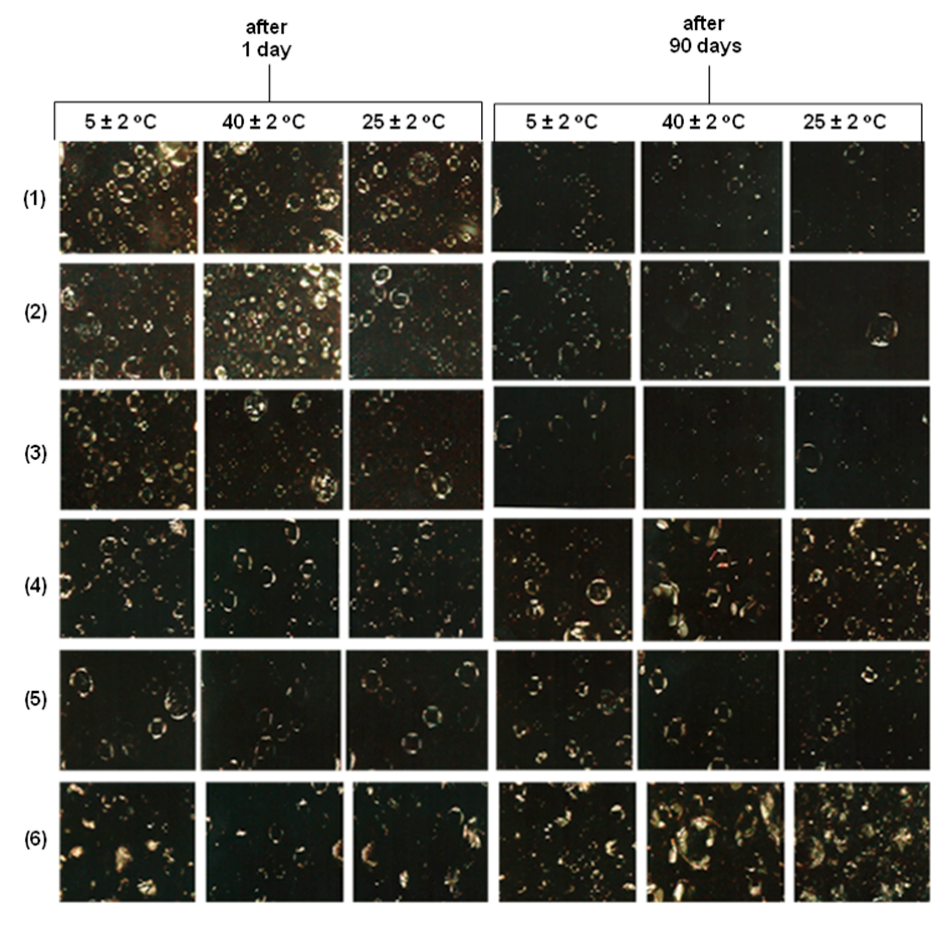
Figure 6. Polarized light photomicrographs (200×) of the formulas doped with 1.0% ester: ( 1 ) Isopropyl Myristate, ( 2 ) Cetyl Lactate, ( 3 ) Capric Caprylic Triglycerides, ( 4 ) Cetyl Esters, ( 5 ) Octyl Stearate, ( 6 ) Cetyl Palmitate) stored under different conditions during the Prolonged Stability Test.